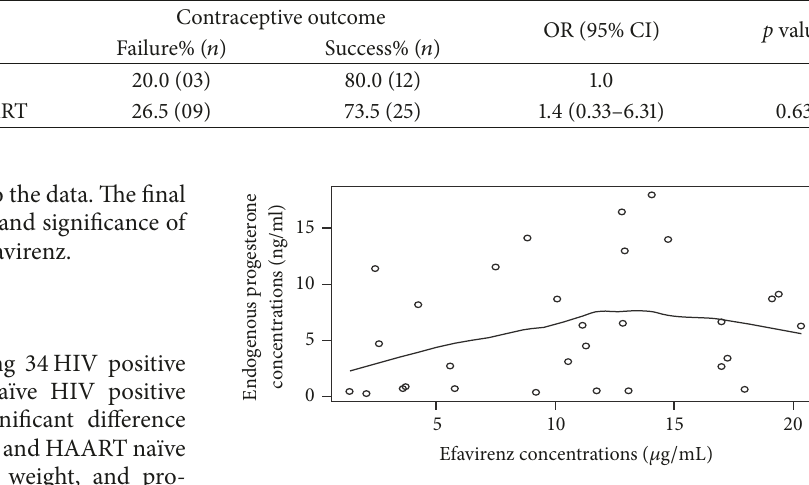
Figure 1: Variation of endogenous progesterone concentrations with efavirenz concentrations for 30 HIV infected women coad- ministering efavirenz and oral pills. Four women on HAART (outliers) were excluded in this analysis. There is a nonsignificant positive linear relationship between progesterone and efavirenz for efavirenz concentrations below 12 𝜇 g/ml. Above 12 𝜇 g/ml of efavirenz, progesterone begins to fall though it is not